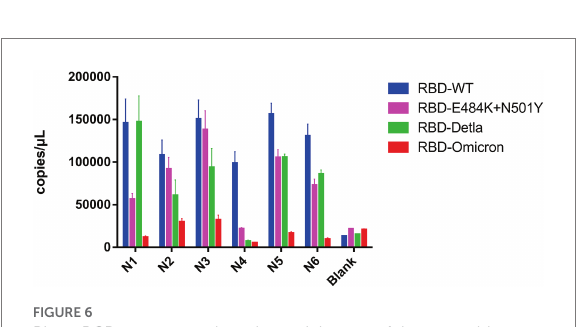
FIGURE 6 Pi-mqPCR assay to explore the enrichment of the recombinant phage-displayed RBD constructs from wild-type SARS-CoV-2 and different variants by six anti-SARS-CoV-2 RBD nanobodies. The values shown are the average of three independent experiments and their standard